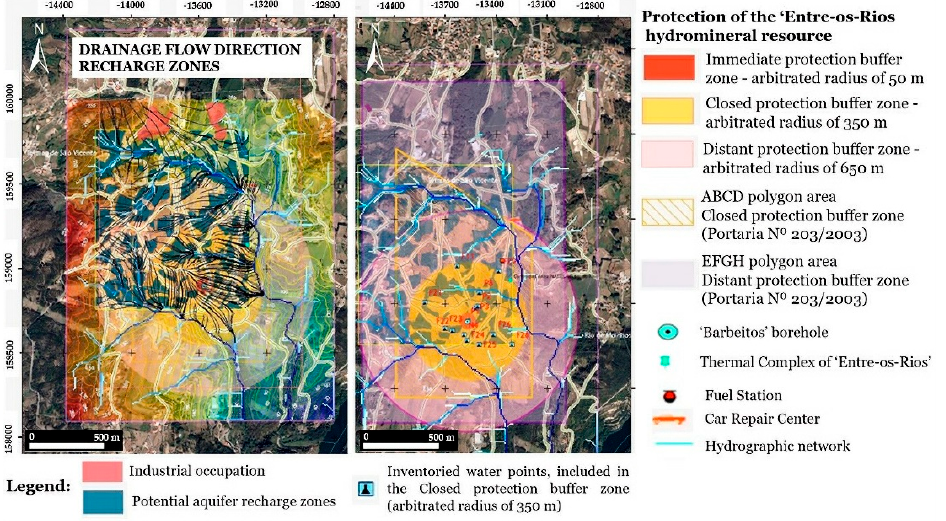
Figure 13. Map of the final considerations of the ‘Barbeitos’ borehole protection zones.